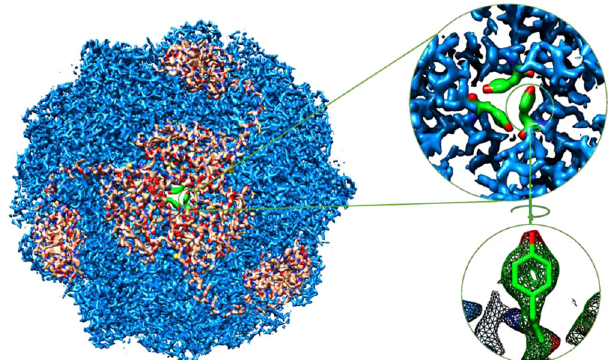
Fig. 1 Cryo-EM density map at 2.0 Å resolution of dodecameric 1.1 MDa Helicobacter pylori urease with bound SHA. Cryo-EM density for copies of UreA (regulatory subunit) are highlighted in light brown and density for tyrosine residues at a threefold axis are highlighted in green (left). Enlarged view of density along a threefold axis of the dodecameric arrangement depicting Tyr15 of UreA (top right). Cryo-EM density (mesh) and fi nal model (solid) of Tyr15 side chain (bottom